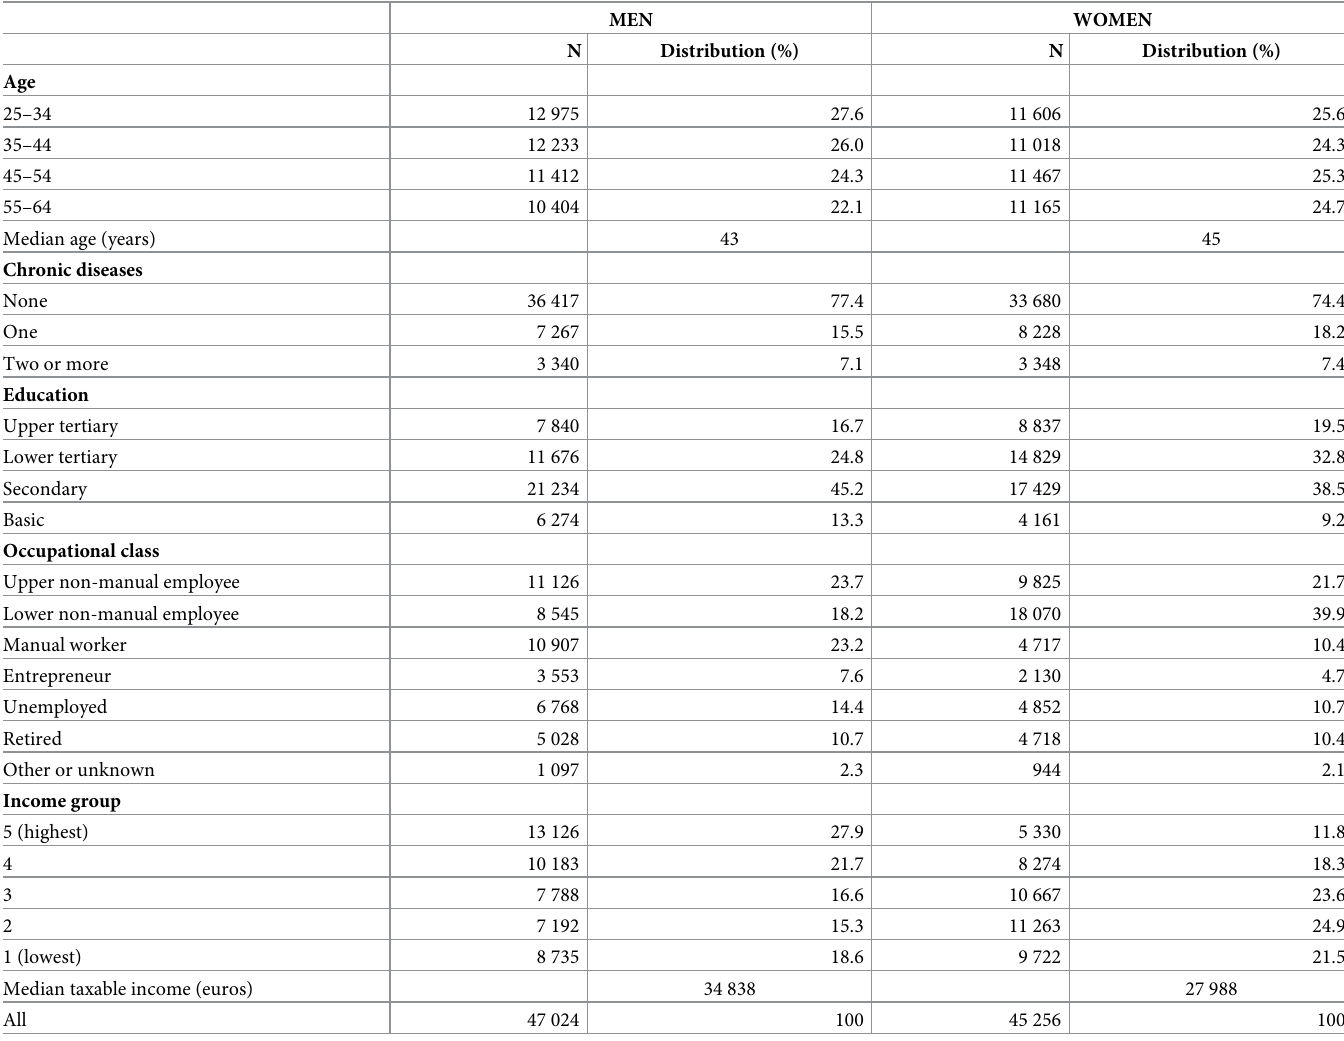
Table 1. Descriptive statistics of the study